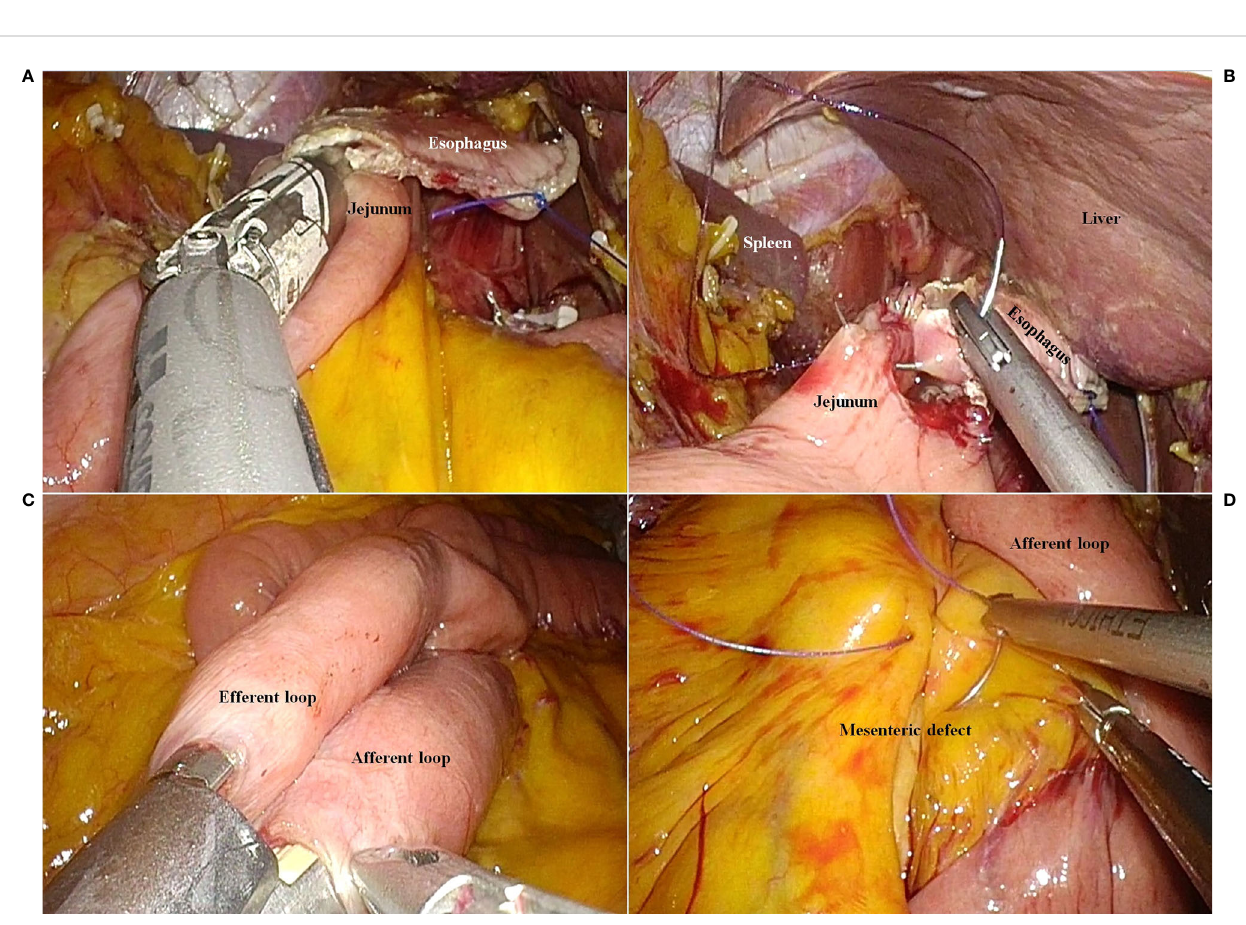
FIGURE 2 The reconstruction procedure. (A) Esophagojejunostomy using a laparoscopic linear stapler. (B) Closure of the common entry hole using a barbed suture material. (C) Jejunojejunostomy using a laparoscopic linear stapler. (D) Closure of the mesenteric defect due to